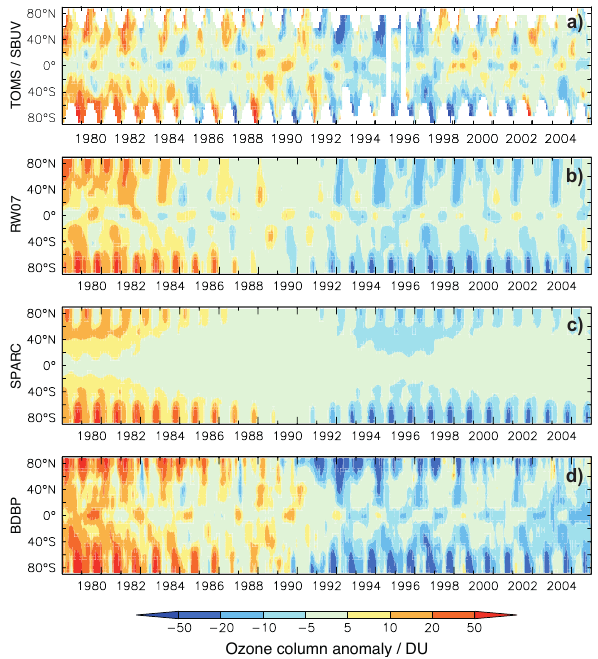
Fig. 3. Total column ozone anomalies (with respect to 1979 to 2005) Figure 3. Total column ozone anomalies (with respect to 1979 to 2005) as a function of time 2 as a function of time and latitude, for (a) TOMS/SBUV and inte- and latitude, for (a) TOMS/SBUV, and integrated ozone, from lowest to highest level 3 grated ozone from lowest to highest level available, for the three available, for the three datasets, (b) RW07, (c) SPARC, and (d) BDBP. White regions in (a) 4 data sets, (b) RW07, (c) SPARC, and (d) BDBP. White regions indicate where no TOMS/SBUV data were available. Blue colours indicate negative 5 in (a) indicate where no TOMS/SBUV data were available. Blue anomalies, red colours indicate positive anomalies. 6 colours indicate negative anomalies, red colours indicate positive